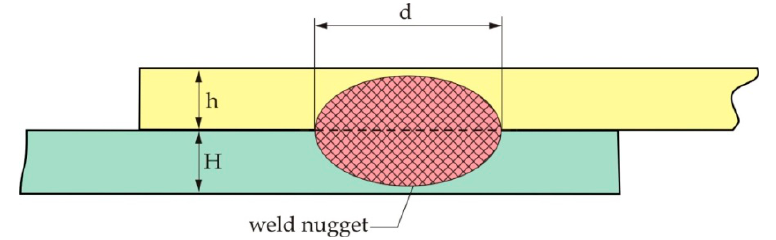
Figure 1. The geometry of the overlap spot-welded joint.